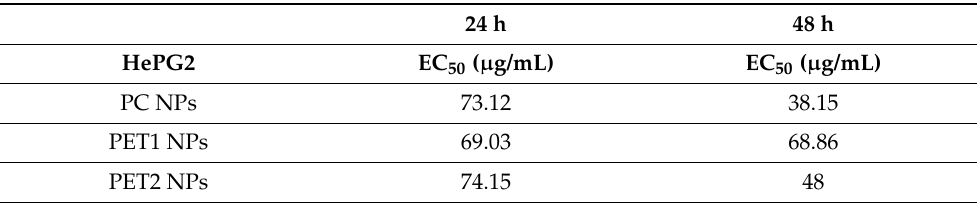
Figure 4. Cell viability of HePG2 and Caco-2 cells exposed to different NPs concentrations or to PC and PET NPs dispersants at 24 or 48 h. Results are expressed as percentage of cell viability compared to the untreated cells. Data are reported as the average of three independent experiments (each run in technical triplicate) ± SD. Valinomycin (900 nM) was used as positive control. p < 0.001, p < 0.01 and p < 0.05 are reported (***, ** and * respectively), calculated versus CTRL (one-way ANOVA). Table 1. The table reports EC 50 values ( µ g/mL) for HePG2 and Caco-2 cells exposed to PC, PET1, and PET2 NPs at 24 or 48